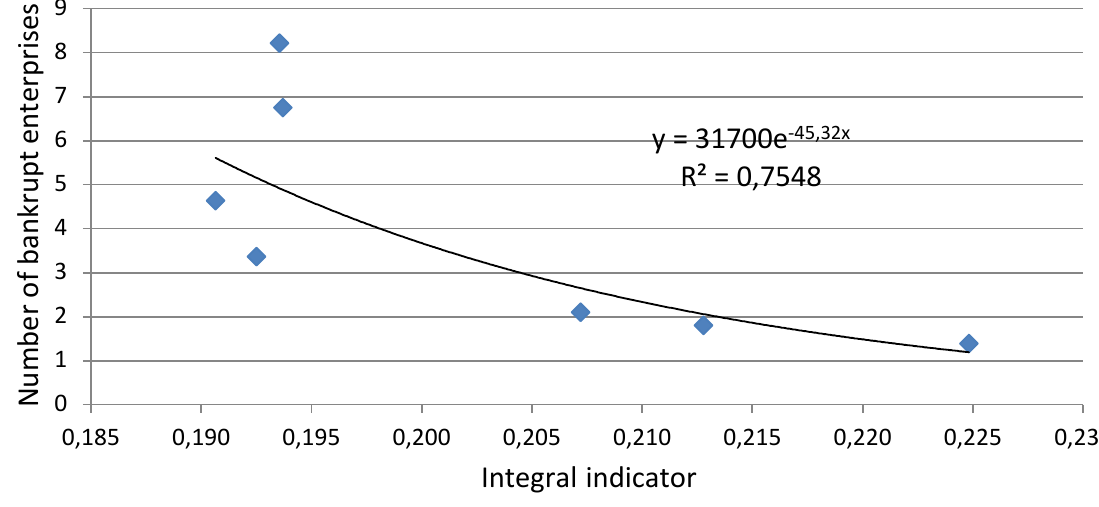
Figure 7. Relationship between the level of business environment security and the number of bankrupt enterprises in Ukraine